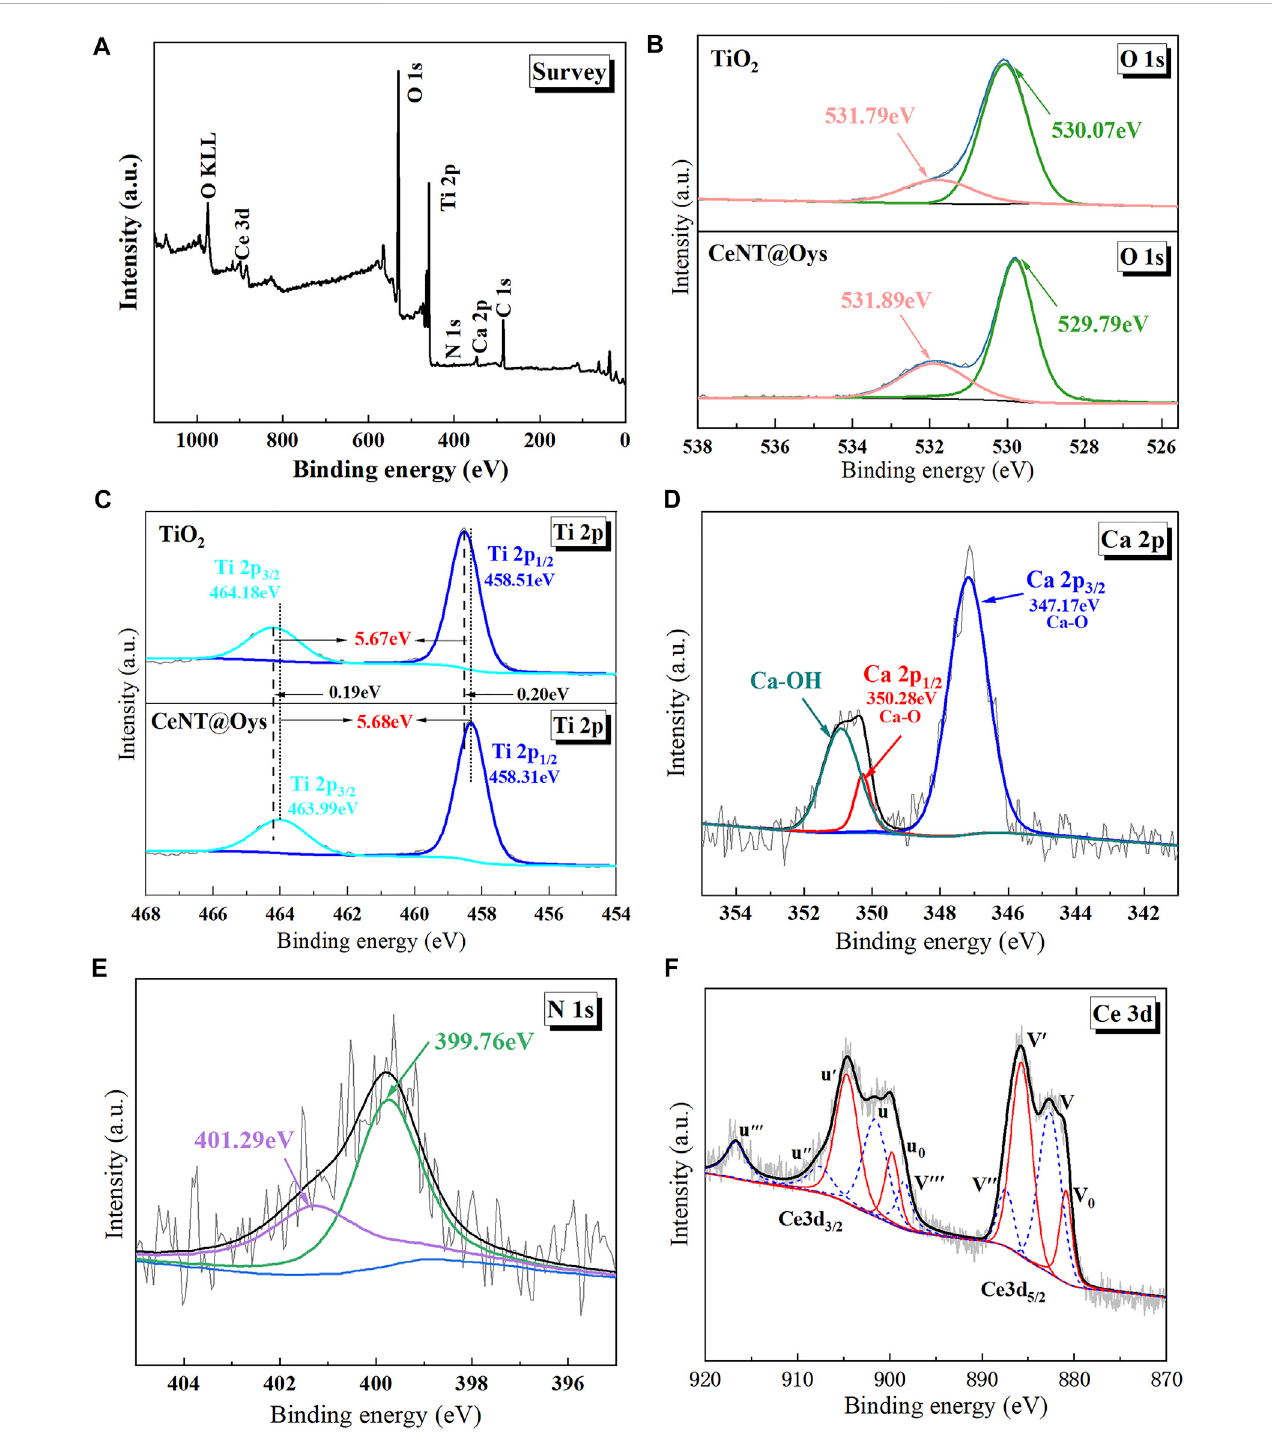
FIGURE 5 XPS spectrum of the CeNT@Oys composite nano-photocatalyst (A) ; high resolution XPS spectra of Ti 2p (B) ; O 1s (C) ; Ca 2p (D) ; N 1s (E) ; Ce 3d (F) .